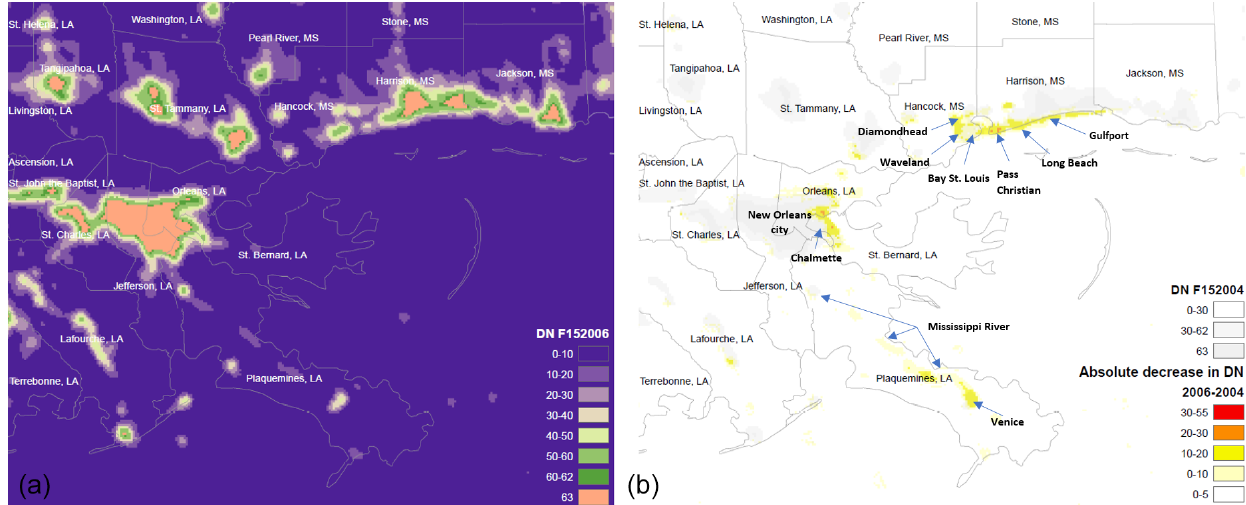
Figure 6. Absolute change in night light intensity from 2004 to 2006. Based on own calculations using satellite F15, corrected with the Elvidge et al. (2014) calibration method. (a) Night light intensity in the study region, year of Katrina 2006. Top-coded pixels are indicated in orange. (b) Absolute difference of pixel value (DN) between 2004 and